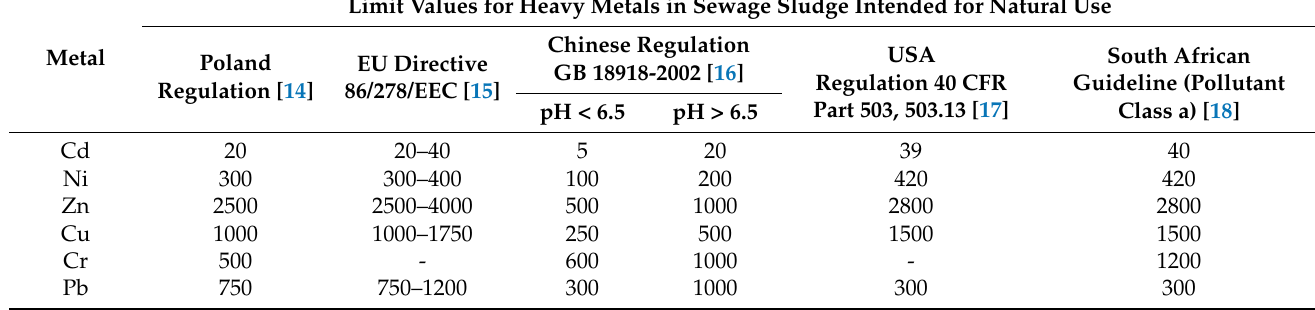
Table 1. Heavy metal limit values in sewage sludge intended for natural use (mg/kg